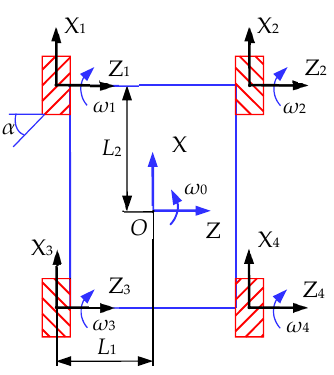
Figure 22. Schematic diagram of the Mecanum wheel robot.